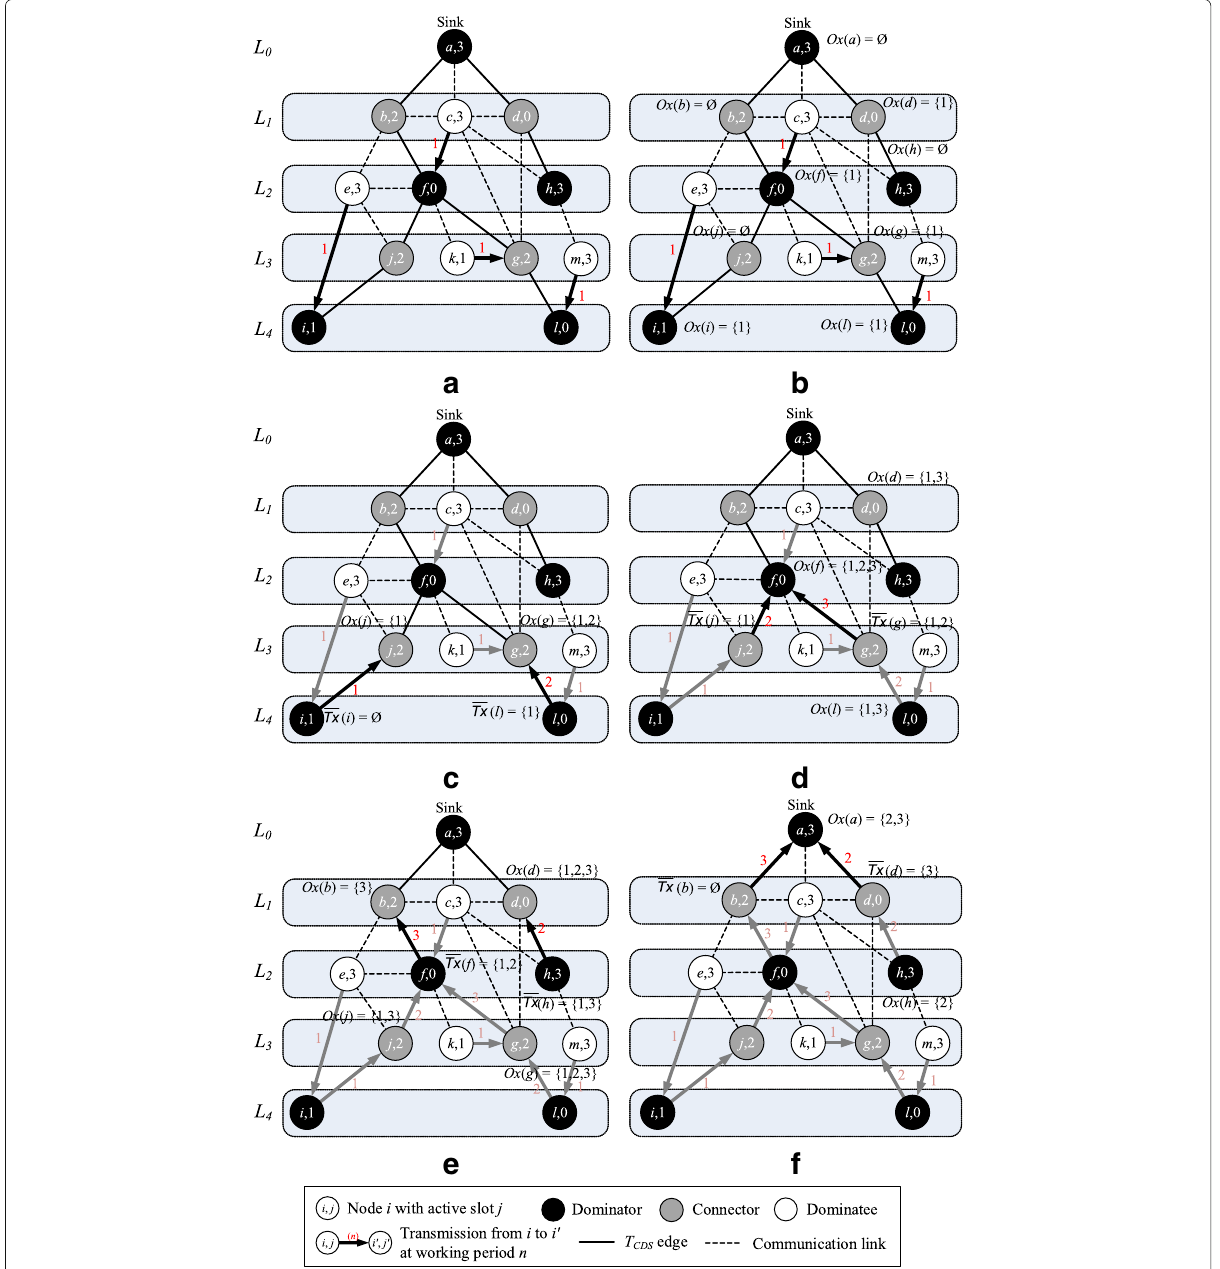
Fig. 4 An example of delay-aware tree construction. a Scheduling dominatees to nodes in T CDS . b Overhearing periods after dominatees scheduling. c Scheduling for nodes in L 4 of T CDS . d Scheduling for nodes in L 3 of T CDS . e Scheduling for nodes in L 2 of T CDS . f Scheduling for nodes in L 1 of T